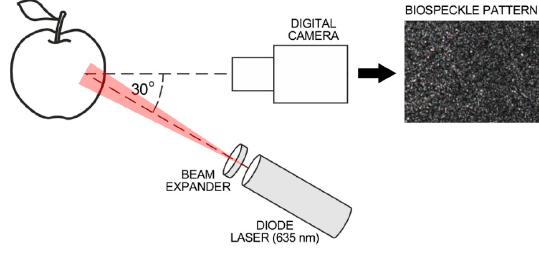
Figure 1. Schematic illustration of biospeckle measurement system.